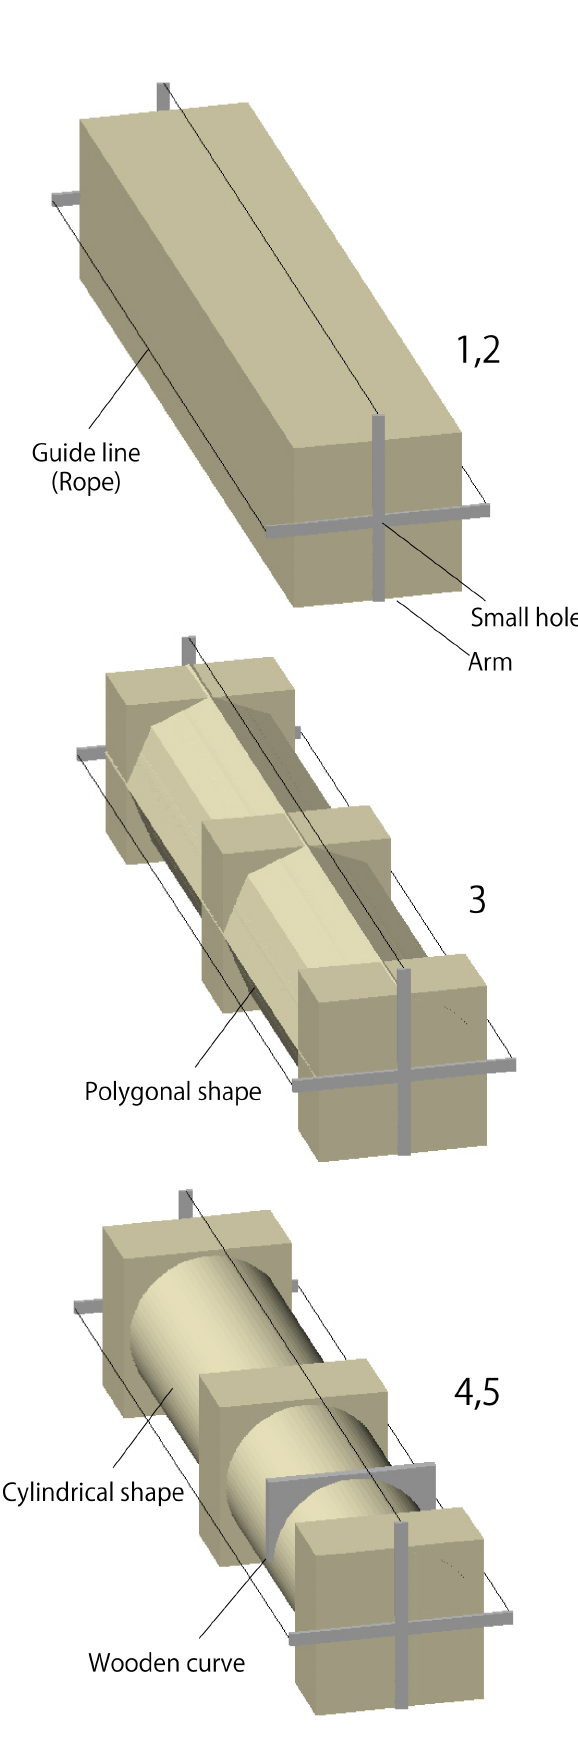
Fig.10 The restoration model of the procedure of the